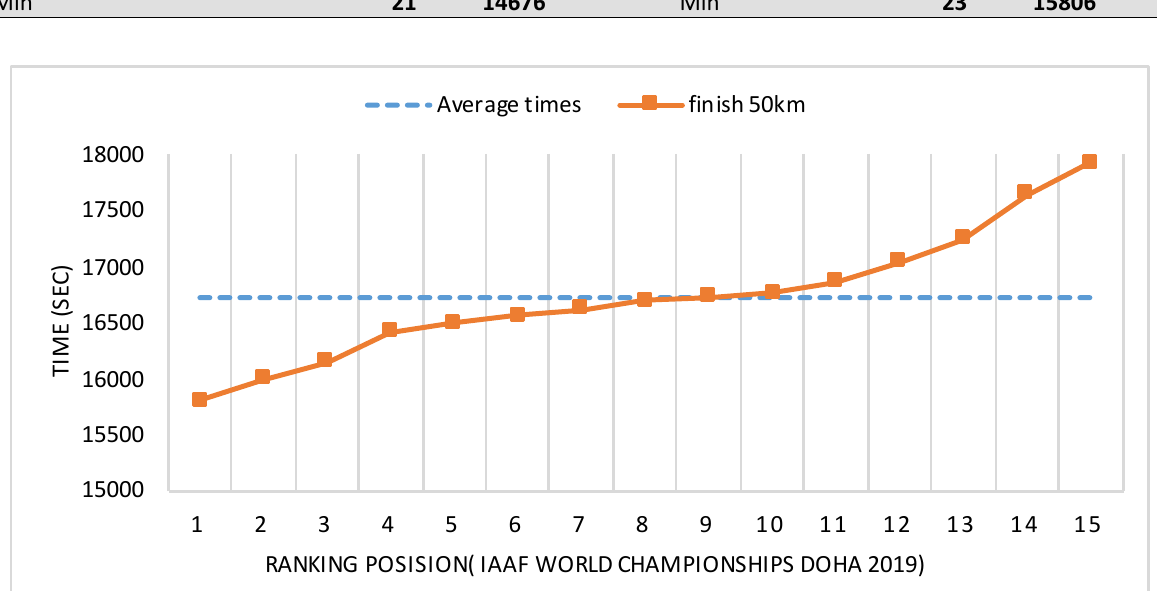
. The performance time of women’s 50km racewalking in relation to their classification position for Figure 1 a